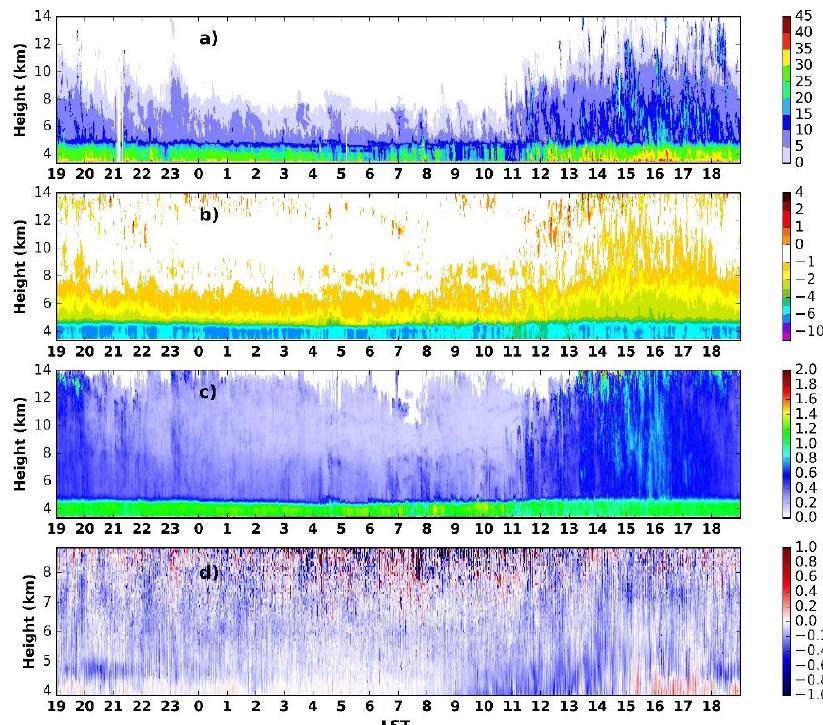
Figure 12. Diurnal cycle of cloudiness and vertical wind, ( a ) Reflectivity (dBZ), ( b ) Doppler velocity (m / s), ( c ) Spectral width (m / s) and ( d ) vertical wind (m / s) calculated from wind profiling radar. Figure 13 shows the hourly mean of brightness temperature for austral summer. At 11 (Figure 13a) and 12 LST (Figure 13b), cold clouds are observed in the east side of the Mantaro valley. Meanwhile, warm clouds predominate above the west side at the same time. In the afternoon (from 13 LST), the clouds move towards the east and deep cold-topped clouds appear in the west side, probably associated with the incoming moisture fluxes from the Pacific Ocean that enter the Mantaro valley until approximately 18 LST (Figure 12h). At the same time, moisture fluxes from the Amazon basin enter through the east side of the Mantaro valley and generate intense cloudiness from 15 to 17 LST (Figure 13e,f). Probably, the interaction between moisture fluxes coming from the west side (Pacific Ocean) and the east side (Amazon basin) of the Mantaro valley generates intense convective activity associated with the occurrence of thunderstorms and heavy rains as in the case studies discussed by [22,25]. This dynamic process coincides with the decay of the direct e ff ect of solar radiation. Instead, during the night, the dynamics of the clouds behaves di ff erently. Storm clouds developed above the Amazon basin, (Figure 14) and due to the anticyclone circulations at mid and upper levels of the atmosphere, these cloud systems strongly influence the rains occurring in areas of the Central Andes. In general, the rains that are registered in the Mantaro valley are fed mainly by those two sources; one on the north side of the valley and the other on the south side (Figure 14b,e,f,g) which means that the moisture fluxes that enter mainly through these two regions play a fundamental role in the rains that are registered inside the valley, as pointed out by